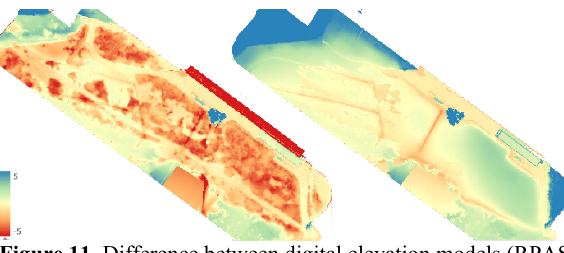
Figure 11 . Difference between digital elevation models (RPAS 2020-RPAS LiDAR 2022) in Santa Barbara site (site 2). Left: Figure 9 . 2020 RPAS survey digital elevation model compared height difference without vegetation removal of initial survey DEM, right: height difference with vegetation with prior 1:2.000 digital elevation model (1999) for the south west area subjected to negligible height changes between 1999 and 2020.